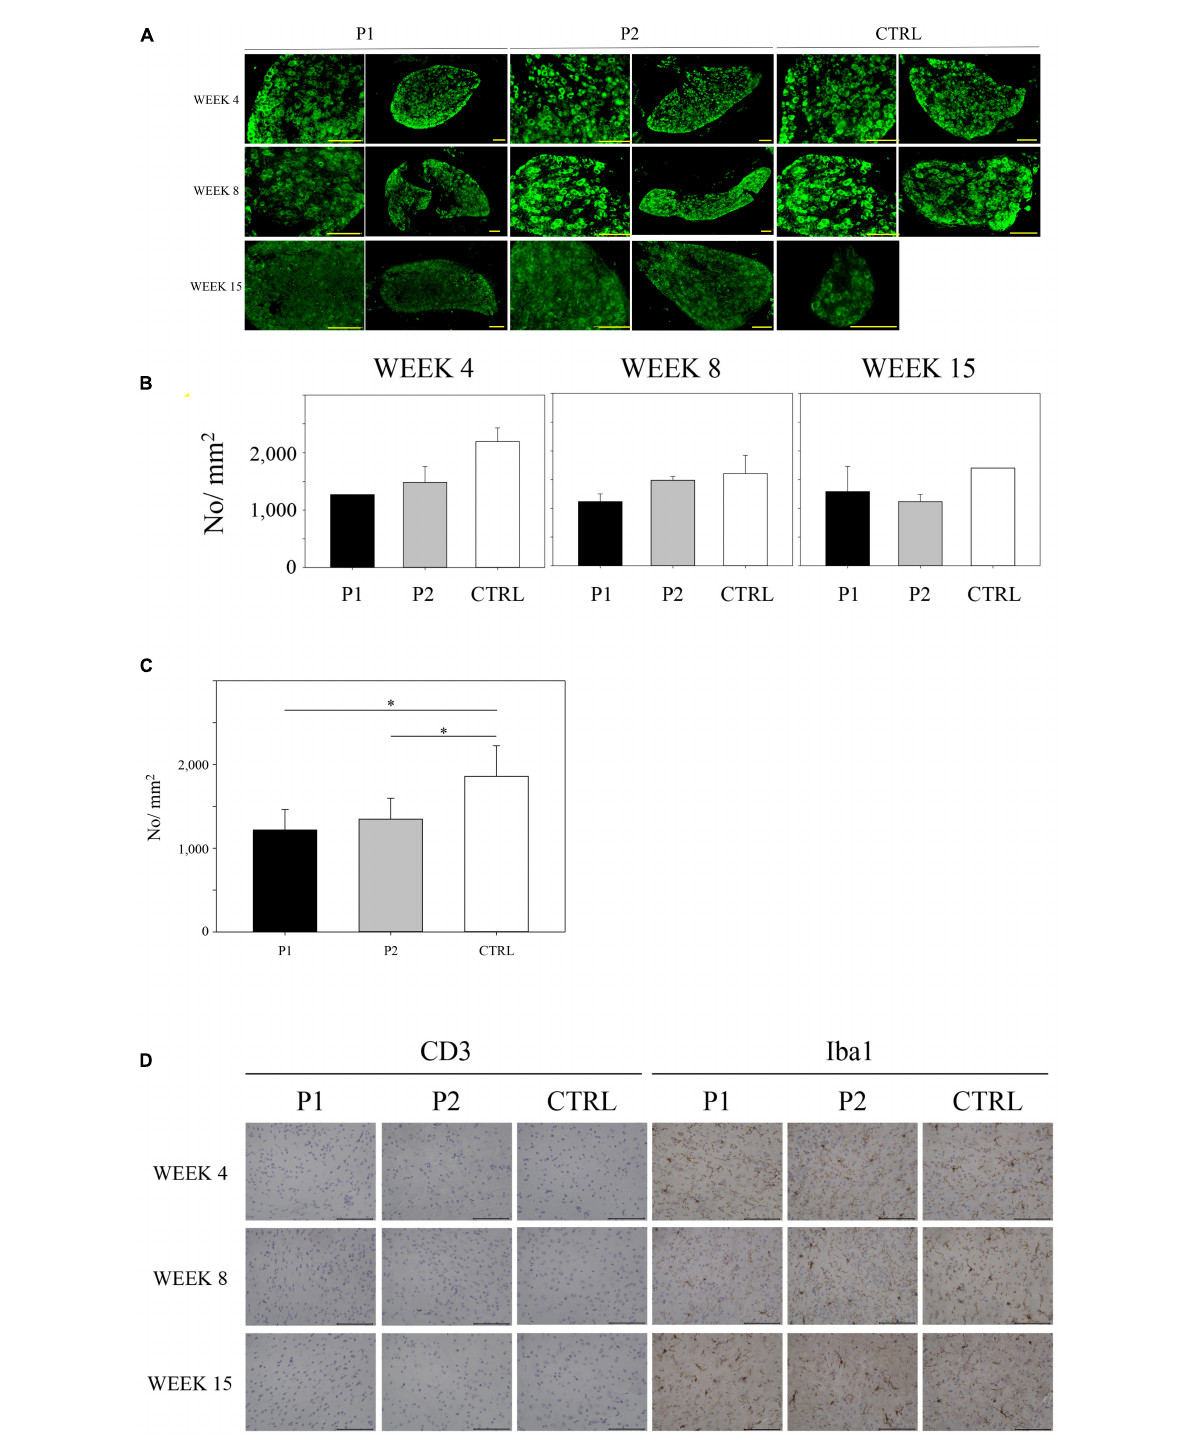
FIGURE5 Immunohistochemical studies on sympathetic cervical ganglia (SCG) and brain. (A) Single-labeled using antibodies specific for the nAChR α 3 subunit of each group at each timepoint. (B) Neuronal cell density (NCD) in SCG at weeks 4, 8, and 15. (C) The mean No./mm2 value for the control mice across all time points was 1860.3 ± 364.5 ( n = 5). This level was significantly higher than that obtained for other groups because the No./mm2 values totaled 1217.8 ± 246.2 ( n = 5) and 1348.4 ± 249.6 ( n = 8) for P1- and P2-immunized mice, respectively ( p = 0.006 by one-way ANOVA). All bar graphs represent means ± standard deviation. (D) Immunohistochemical studies of brain CD3 and Iba-1. Scale bar: 200 µ m. Asterisk denotes statistical